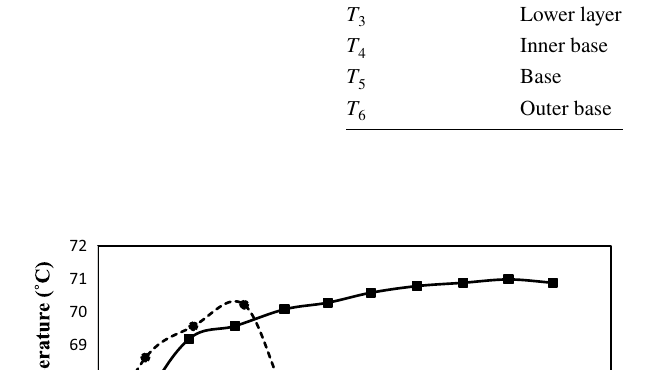
the thermocouples in the heat transfer setup (Clarke and Pruden 1997)